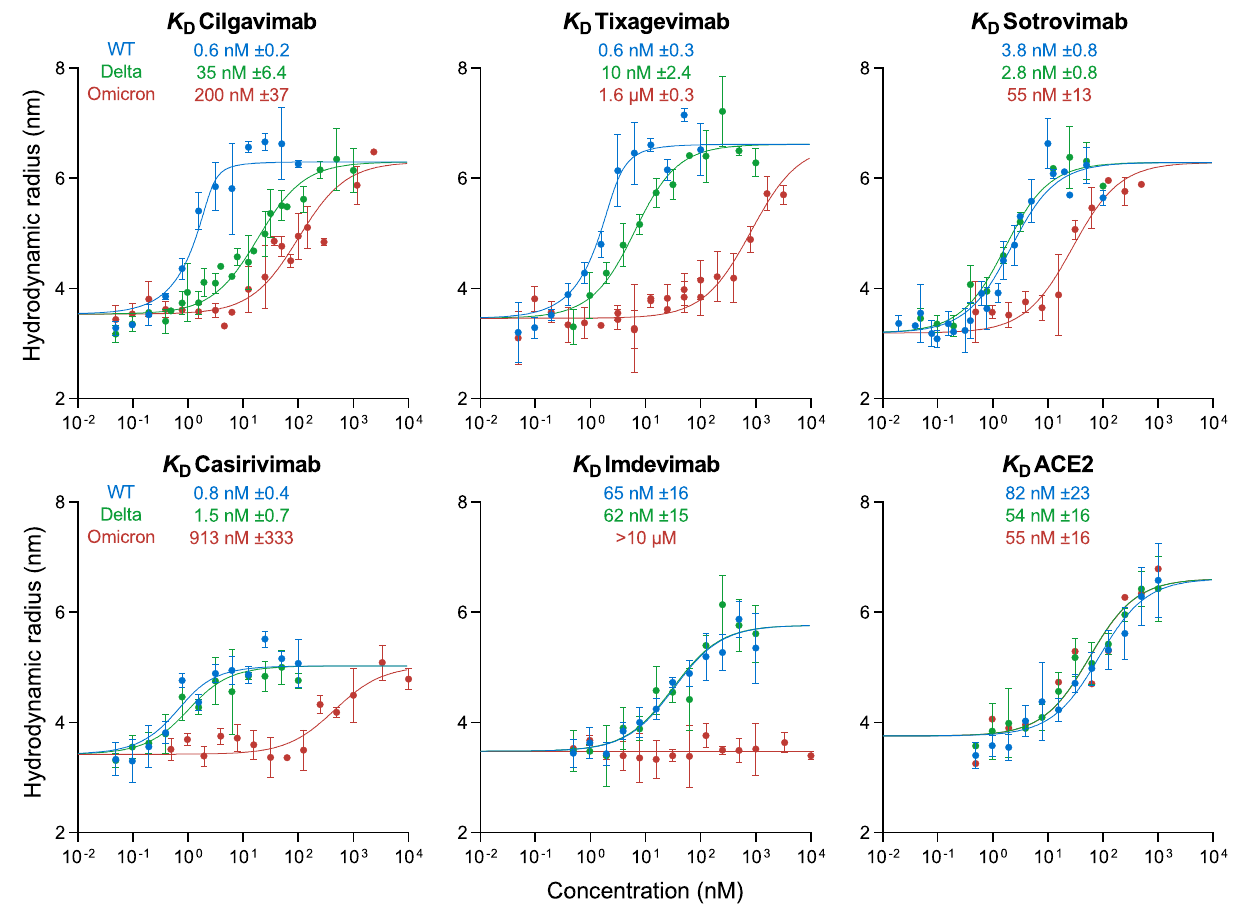
Figure 1. Equilibrium binding curves of cilgavimab, tixagevimab, sotrovimab, casirivimab, imdevimab, and ACE2 binding to spike RBD proteins from SARS-CoV-2 wild type (blue) as well as variants Delta (green) and Omicron BA.1 (red) as determined by microfluidic diffusional sizing (MDS). Error bars are standard deviations from triplicate measurements. K D values are best fits with standard errors from non-linear least squares fits in terms of a 2:1 binding model (antibodies) or a 1:1 binding model